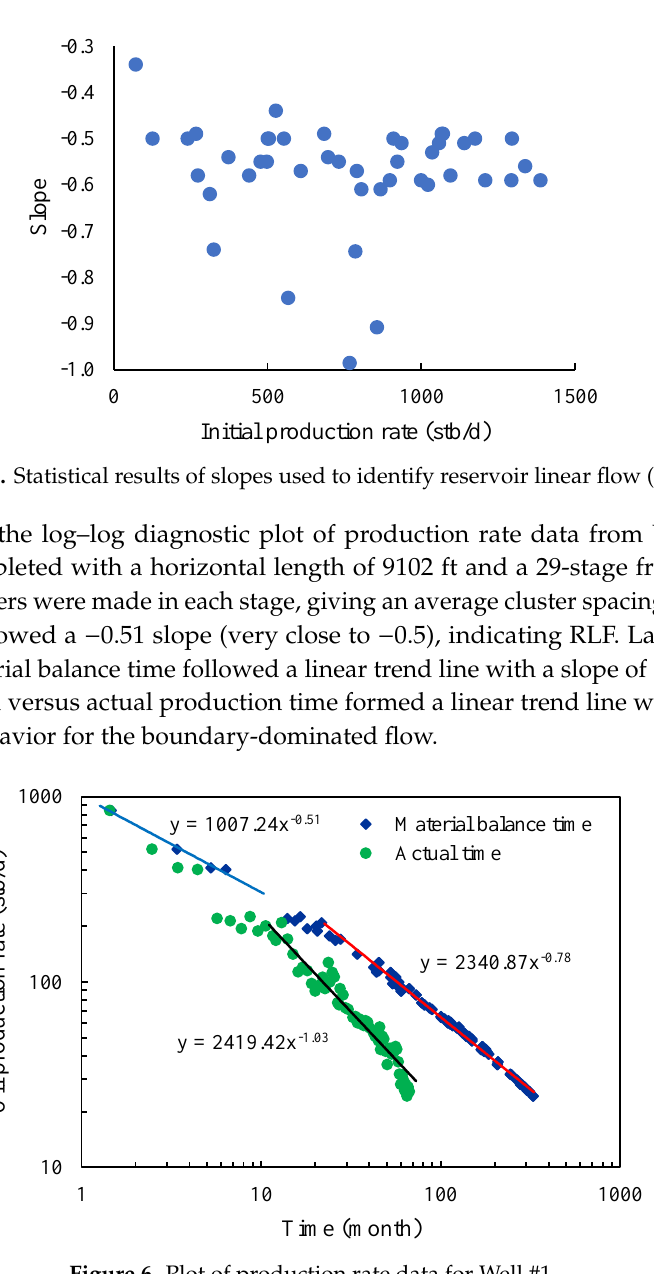
Figure 5. Statistical results of slopes used to identify reservoir linear flow (RLF).